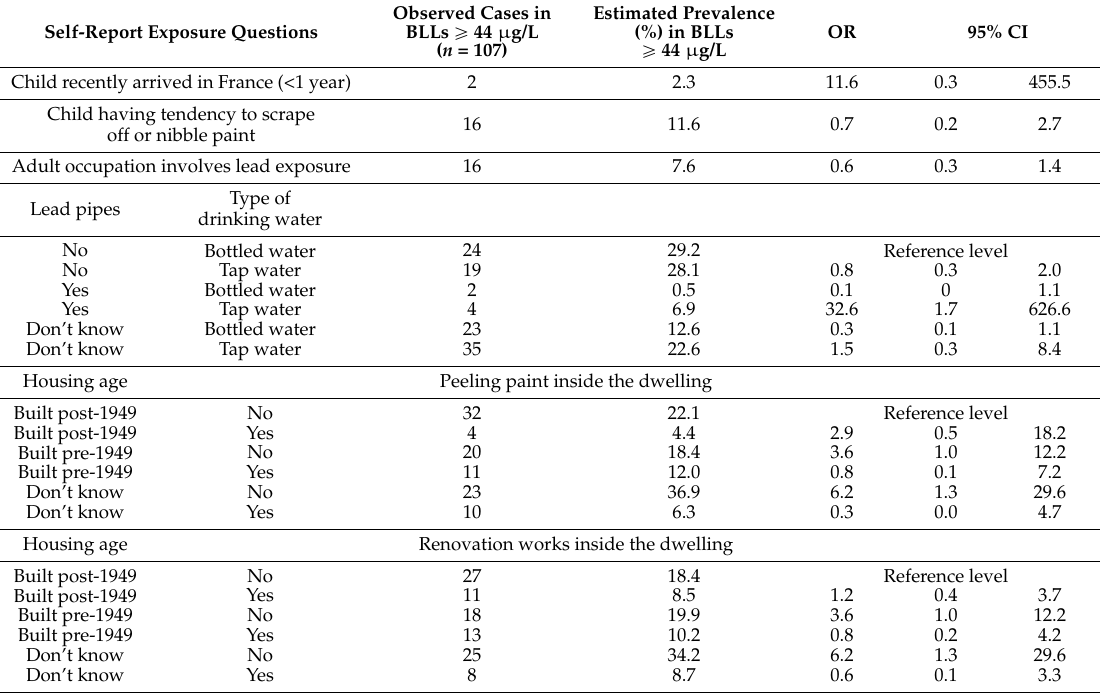
Table 3. Associations between current French screening criteria and BLLs ě 44 µ g/L ( n = 2445) in children, France 2008–2009. Results from the logistic multivariable regression